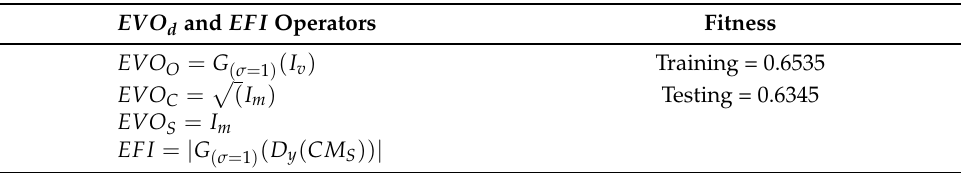
Table 14. Program structure of the operators corresponding to the best solution for the IMGSAL database. We select this solution from the 30 executions of Table 13. This final solution is also simple, using a filter and square root for the first two operators, I m for the third, and the absolute value of filters and derivatives over the conspicuity map of